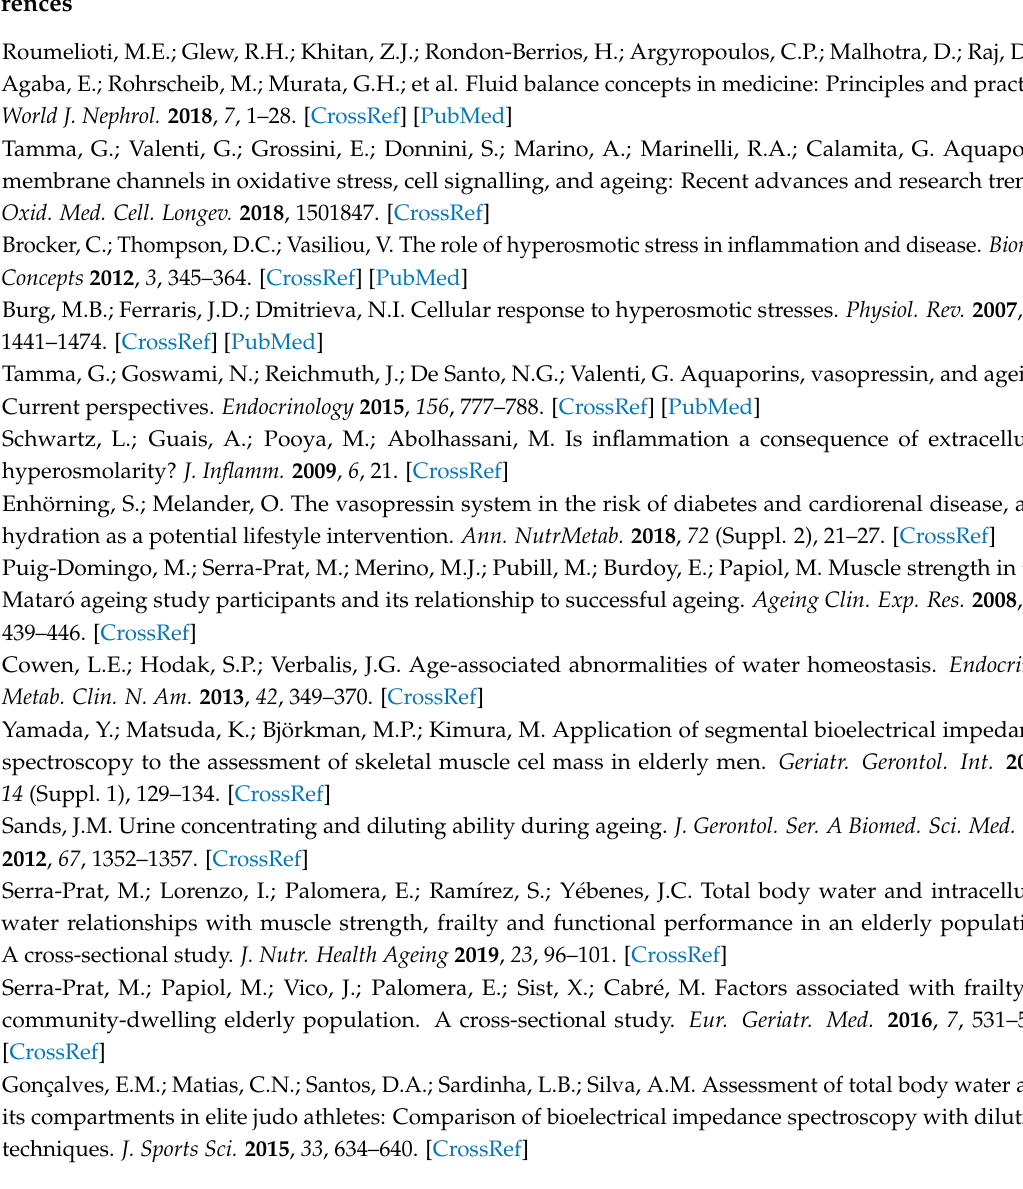
Table S1: Relationship between Lean Mass (kg) and indicators of muscle strength and functional capacity (continuous variables), Table S2: Relationship between Lean Mass (kg) and indicators of functional capacity and frailty (categorical